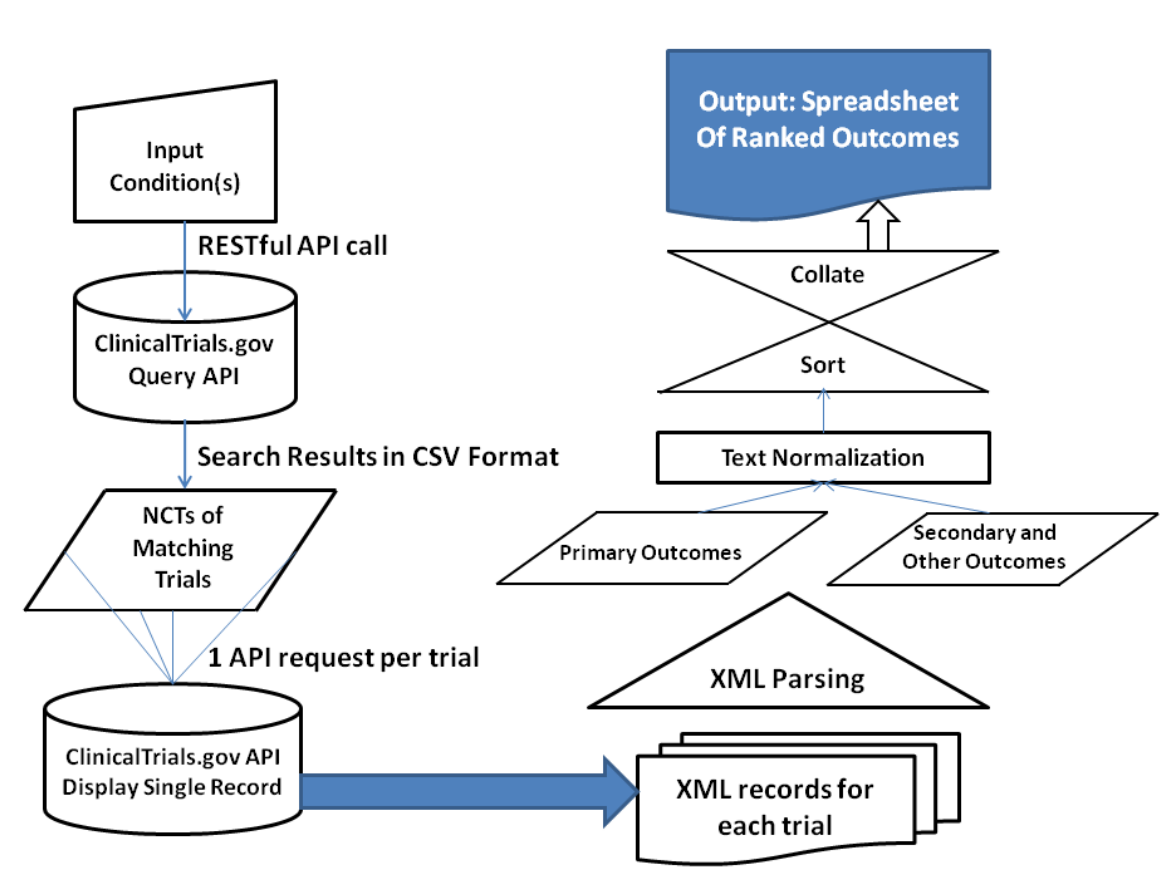
Figure 1. Pipeline